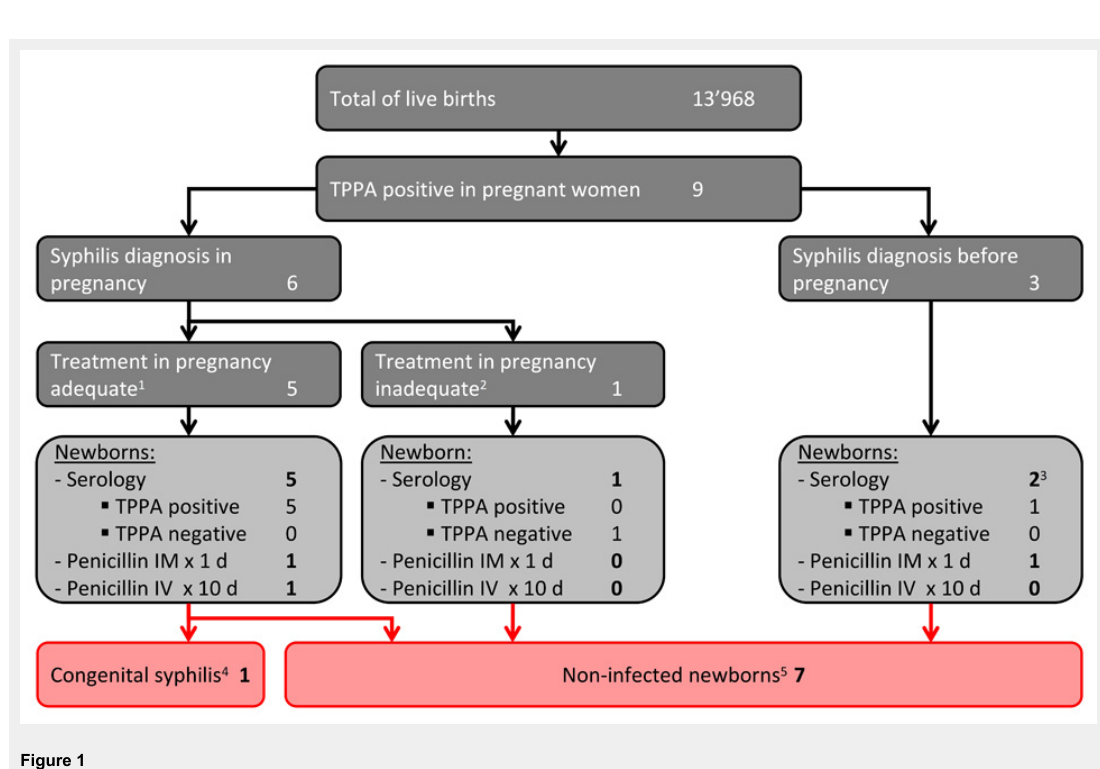
Antenatal syphilis serology, Triemli Hospital Zurich, 2000–2009. 1 Adequate treatment: documented treatment with a penicillin regimen according to current guidelines, and completed ≥4 weeks prior to delivery, and no evidence of treatment failure (as might be suggested, e.g., by unchanged or increasing VDRL titers), and no evidence of syphilis re- infection or relapse. 2 Inadequate treatment: no treatment, no documentation of treatment, treated with a non-penicillin regimen, evidence for treatment failure or treatment completed <4 weeks prior to delivery. 3 One newborn tested only with IgM EIA and without TPPA. 4 Symptomatic disease with IgM EIA test positive and abnormal placental exam (Appendix 2). 5 All parts of the infant’s evaluation normal and in 7 of 8 newborns negative syphilis serology (IgM test negative, VDRL <4-fold than maternal VDRL, and placental exam negative (if performed)) (Appendix